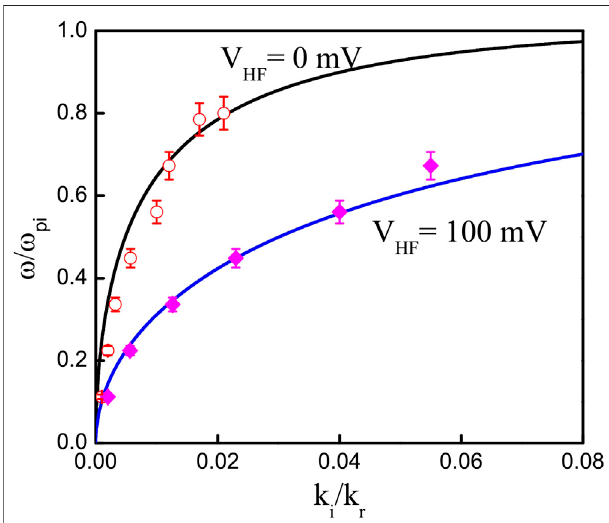
FIGURE 4 | Normalized wavenumber ω / ω pi as a function of the spatial damping rate k i / k r . The solid curves are theoretically obtained from Eq. 2 . The open and closed symbols are experimentally measured values at V HF (cid:2) 0 and V HF (cid:2) 100 mv, respectively.